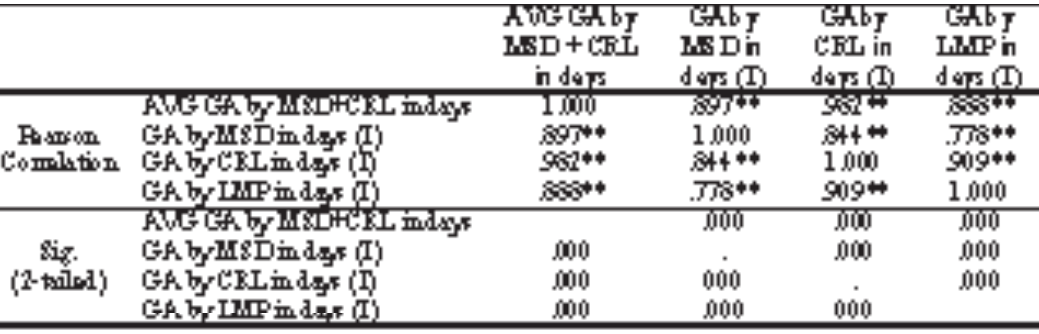
AVG GA = Average gestational age in 1 st Trimester.